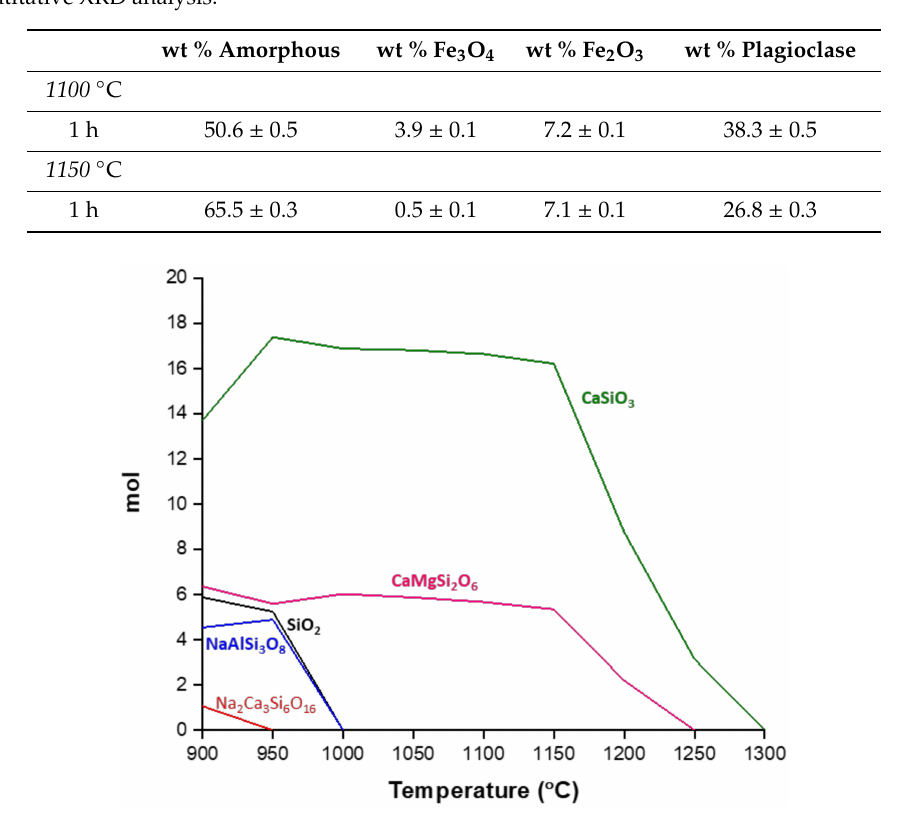
Table 4. The phase composition of powder volcanic ash glass samples after heat treatment using quantitative XRD analysis.